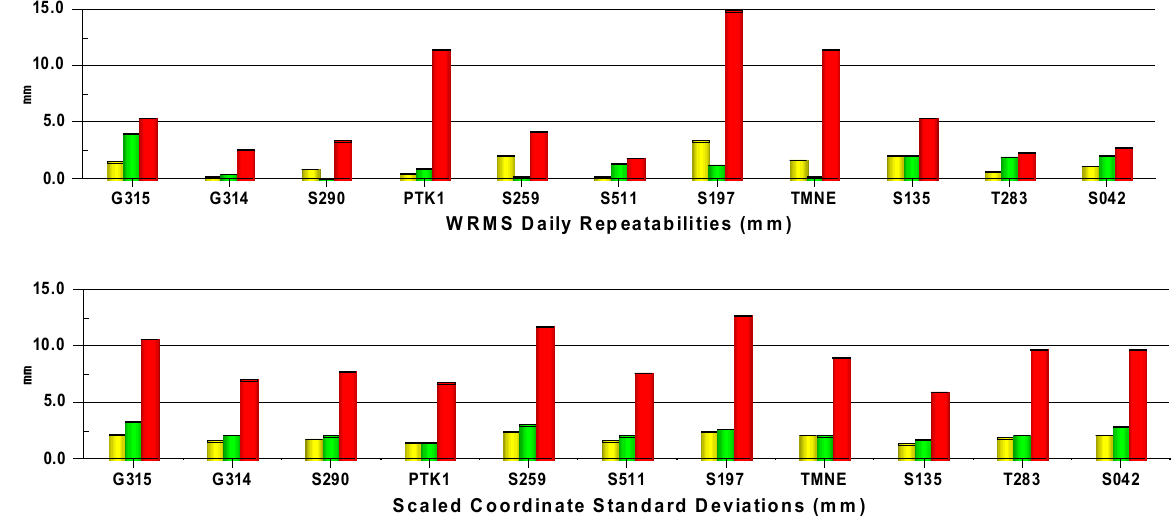
Figure 4. Overview of the IGS14 position error estimates for eleven (11) TG benchmarks in the north (yellow), east (green), and vertical (red) directions. TG benchmarks. In the top panel, the WRMS of the daily offsets with respect to the 6-day averaged solutions are shown (the daily coordinate repeatability). The bottom panel shows scaled (by a factor of 1.67) standard deviations of the 6-day averaged solution for each TG benchmark. Table 2. Differences in ITRF201414/WGS84 geodetic coordinates at TG-GPSBM sites from AUSPOS (Bernese ver. 5.2) and GIPSY-OASIS II solutions (observation period: August–September 2019).